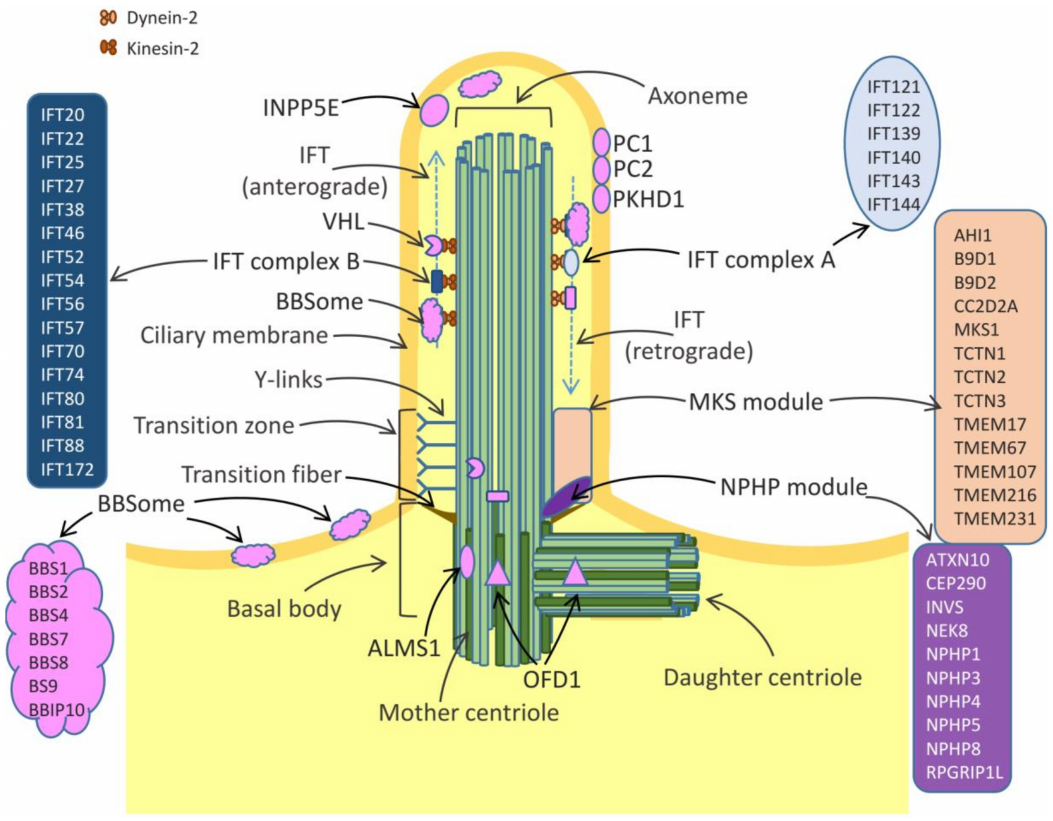
Figure 1. The structure of primary cilium. The axoneme is composed of nine pairs of microtubules, anchored in the cell by the basal body. The latter is a modified centriole, consisting of nine triplets of microtubules. The mother centriole plays a key role in ciliogenesis, recruiting the molecules required for axoneme elongation. The daughter centriole results from duplication of mother centriole during S phase [4]). The arrows indicate the key structural cilium elements (the axoneme, transition zone and basal body) as well as proteins involved in kidney ciliopathies and renal cell carcinoma (RCC)